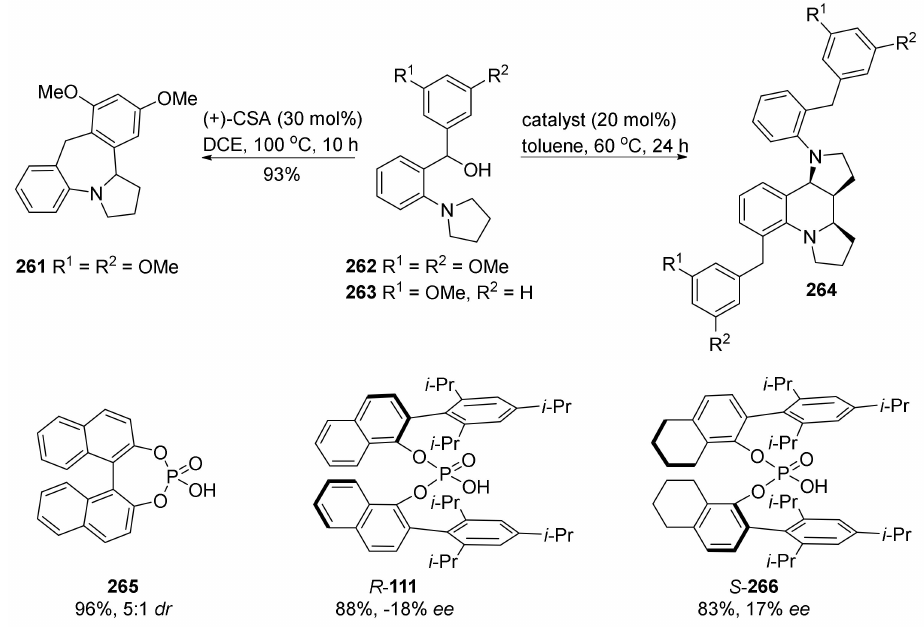
Scheme 45. Scaffold synthesis by Xiao and